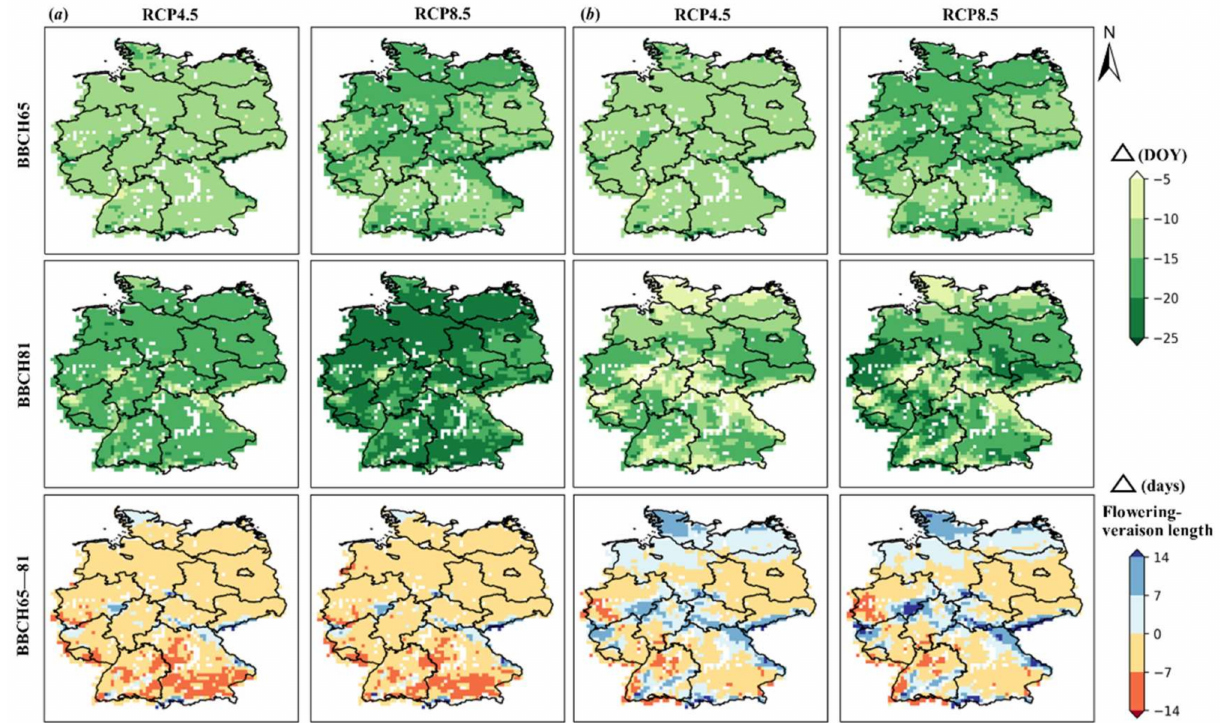
Figure 3. Ensemble median projections for the mean DOY changes of flowering (BBCH65) and veraison stages (BBCH81) and for the BBCH65-BBCH81 phenophase between the future period (2041–2070) under RCP4.5 and RCP8.5 and the baseline period (1976–2005) for grape varieties of ( a ) Müller-Thurgau and ( b ) Riesling. For the phenophase, positive values indicate the extended period, whereas negative values denote the shortened period. DOY: day of year. Negative DOY denotes the advanced days of the phenology